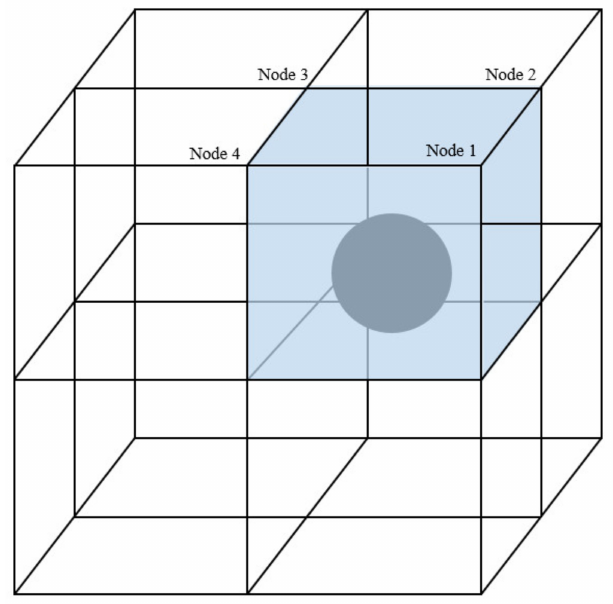
Figure 11. Particle information distribution technique used in Fluent.